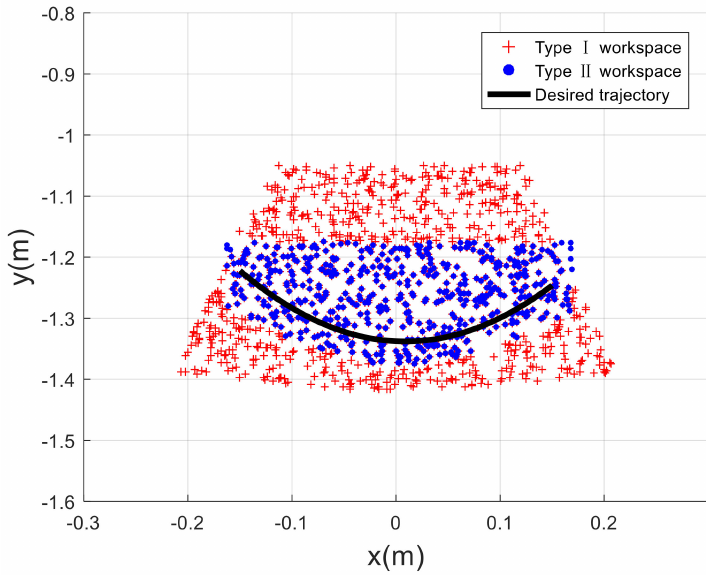
Figure 8. Reachable workspace of